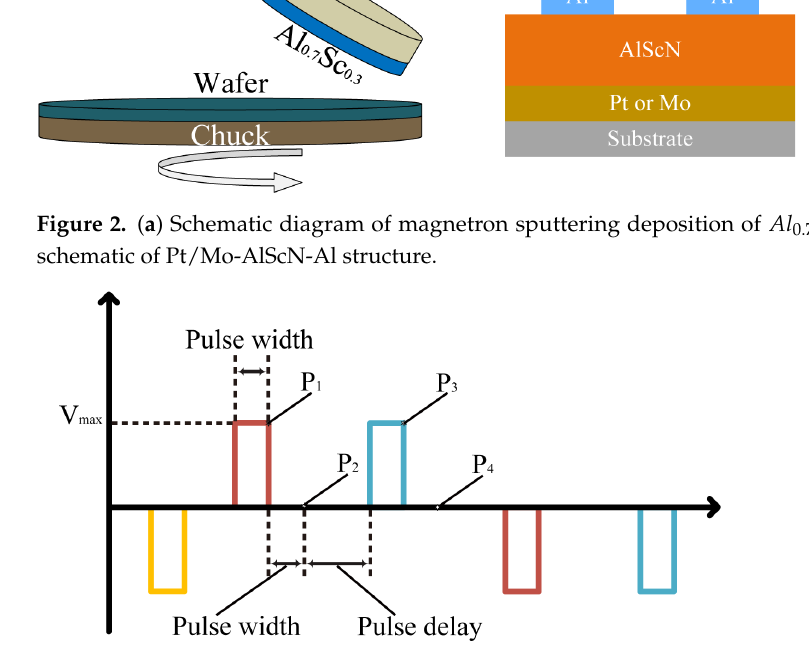
Figure 3. Schematic of the pulse sequence for the PUND test. The pulse intensity is V max , and each pulse maintains a pulse width. When a pulse ends, a pulse width plus pulse delay is waited for in order to input the next pulse. The polarization values are recorded twice for each pulse